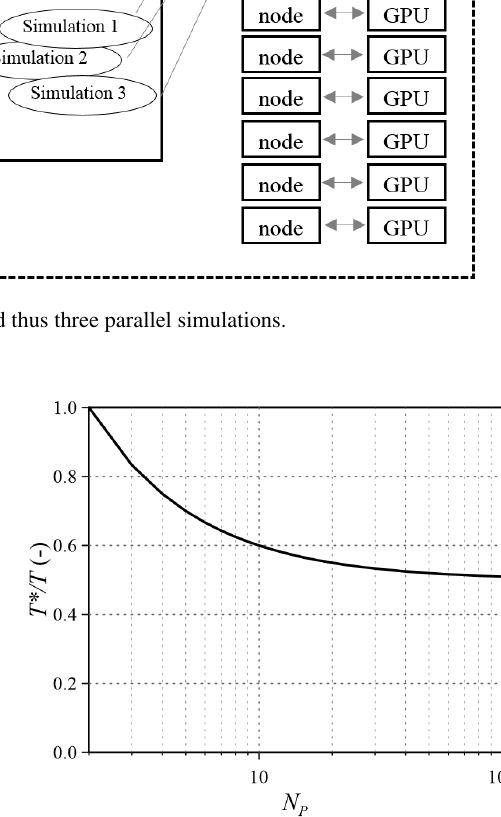
Figure 5. Time reduction T ∗ /T as a function of the number of es- timable parameters (the x -axis is in logarithmic